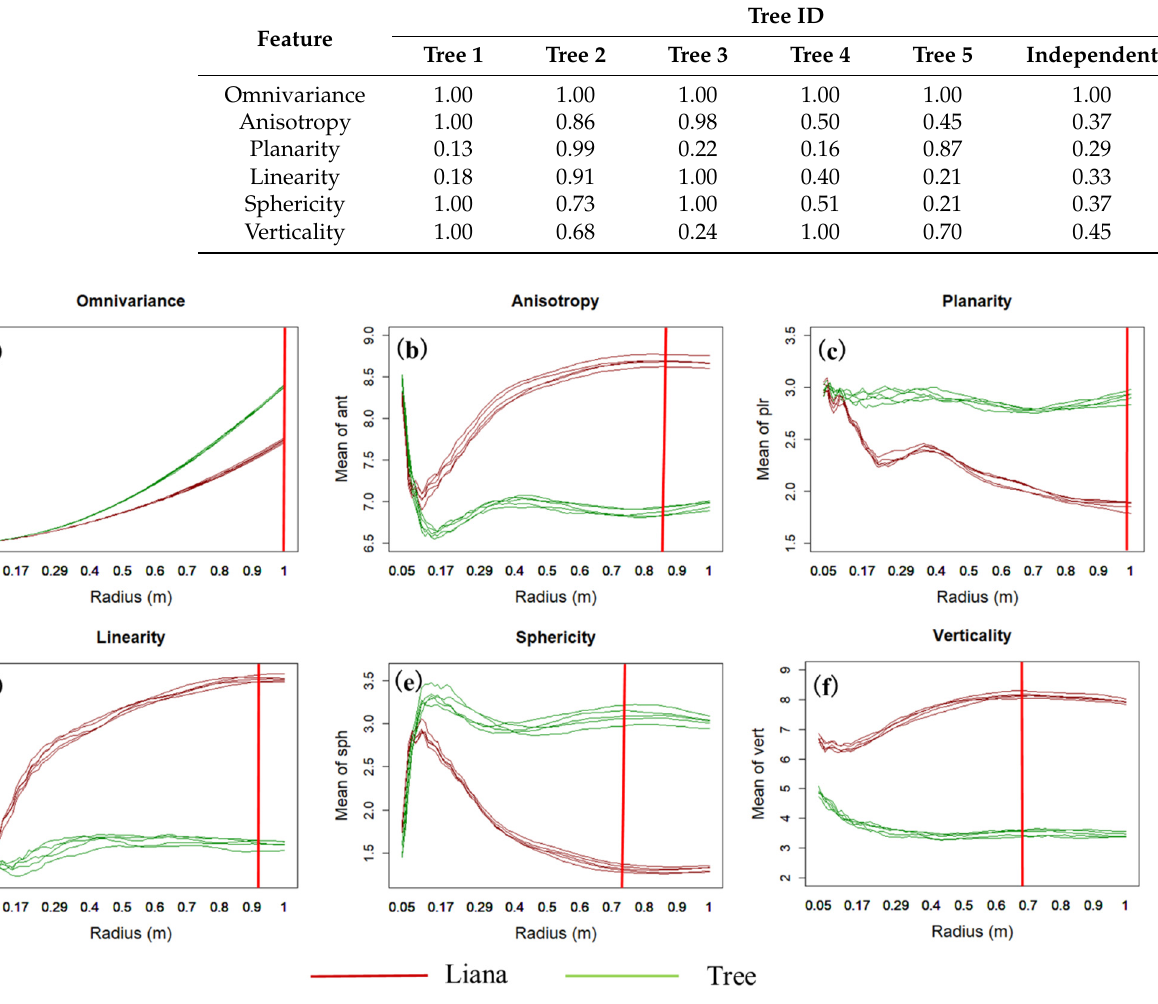
Figure 3. The changing trends of Omnivariance, Anisotropy, Planarity, Linearity, Sphericity and Verticality for Tree 2 across the various radii (y-axis indicates the mean value of each feature, and the x-axis shows the value of radius from 0.05 to 1 m; red line: liana; green line: Tree); red vertical line indicates the optimal radius used in this study (see Table 3).